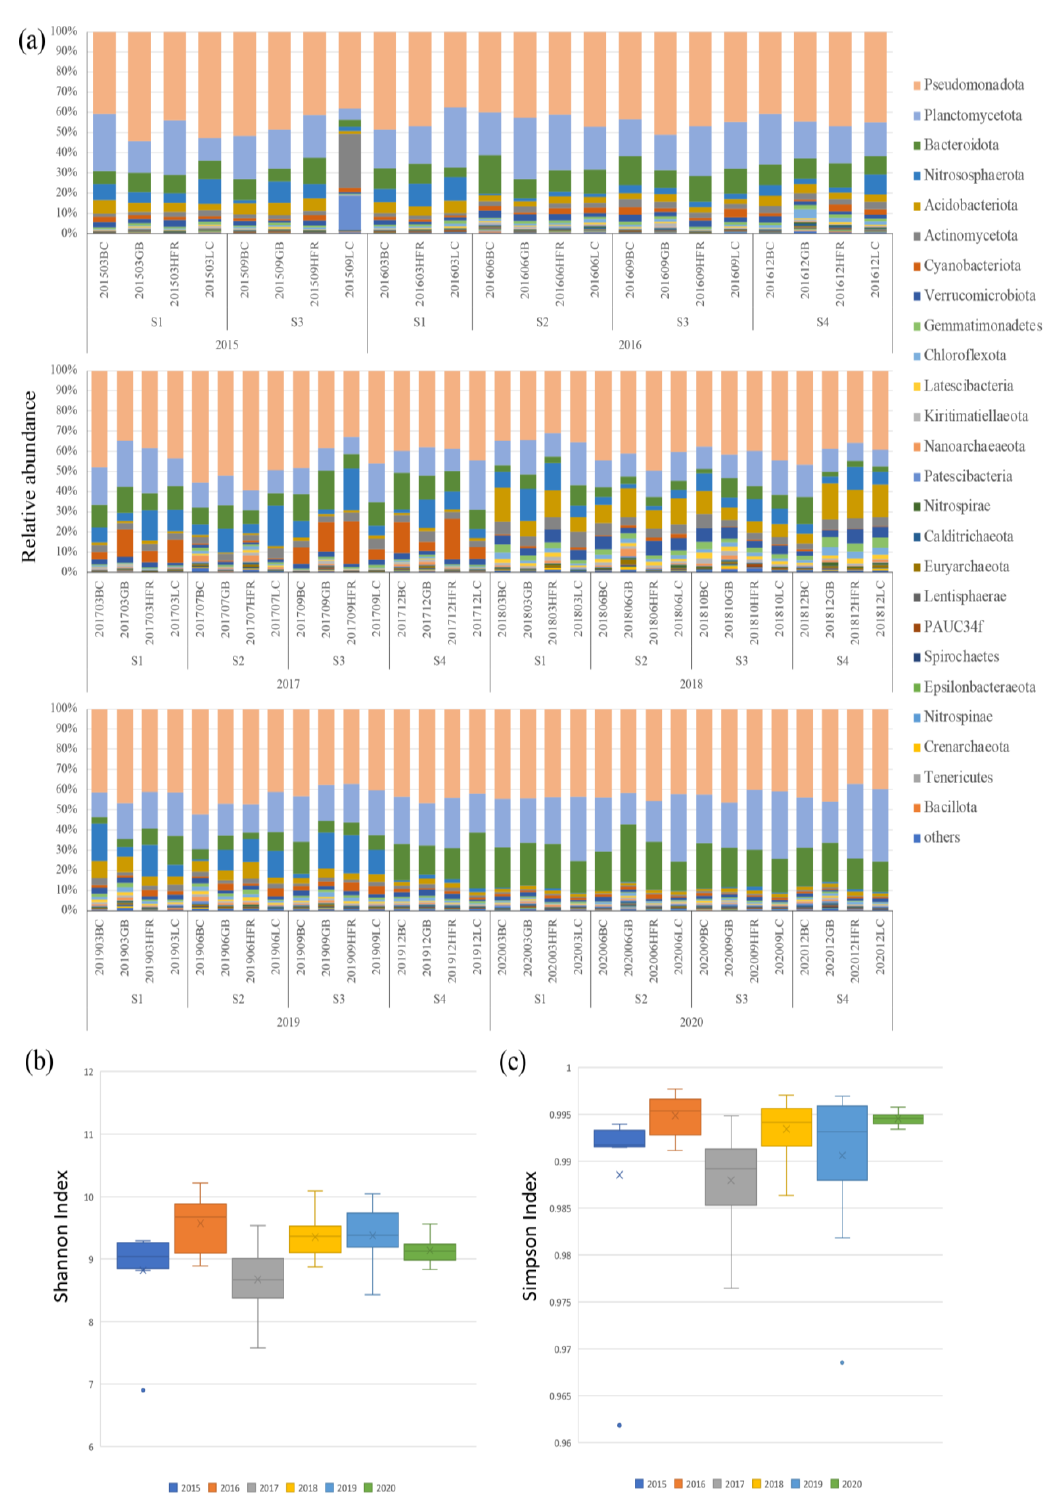
Figure 2. ( a ) The relative abundances of top 25 microbial phyla; ( b ) boxplot of Shannon indices calculated using the OTUs data of different years; ( c ) boxplot of Simpson indices calculated using the OTUs data of different years on Liuqiu Island, Pingtung County, Taiwan. The BC, GB, HFR, and LC in ( a ) indicate the sites Beauty Cave, Geban Bay, Houshi Fringing Reef, and Lobster Cave, accordingly. The x in ( b , c ) indicates the average value of biodiversity index of each group, while the dot was the outsider of each